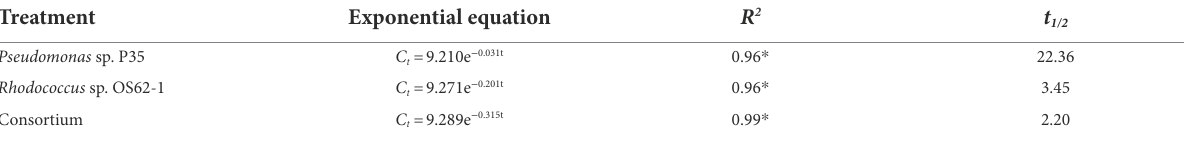
TABLE 1 First-order kinetics equations and the corresponding half-life times of crude oil biodegradation by Rhodococcus sp. OS62-1, Pseudomonas sp. P35, and Consortium at 28 ° C in 7 days. Treatment Exponential equation R 2 Pseudomonas sp.